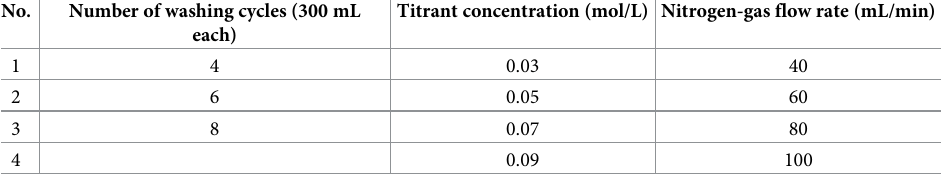
Table 1. Condition optimization